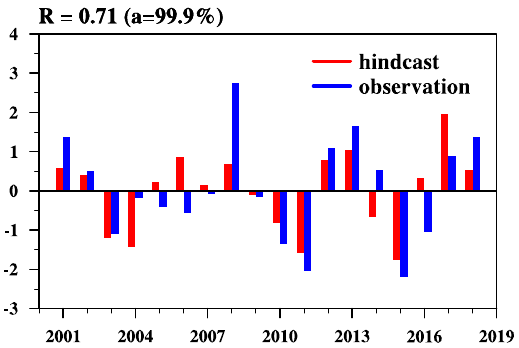
Fig. 6 Cross-validation skill of interannual variation of spring EHE dipole mode. The observed spring EHE dipole mode index (blue bar) and the hindcasted index (red bar) based on the leave-one-out cross-validation method and the winter BK sea ice